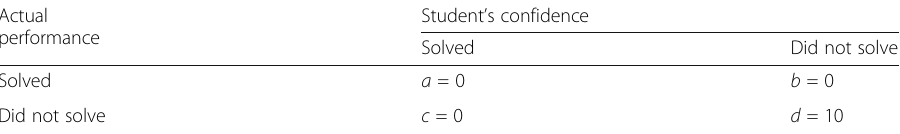
Table 9 a , b , c , and d scores for a given example Actual